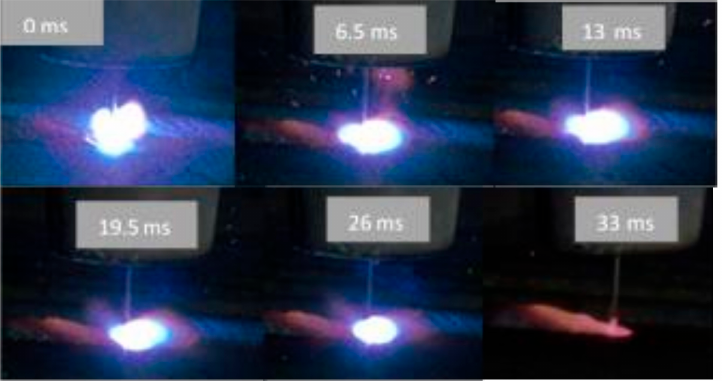
Figure 3. The arc appearance, labeled with the timing from the droplet initiation to detachment, for the binary blend.